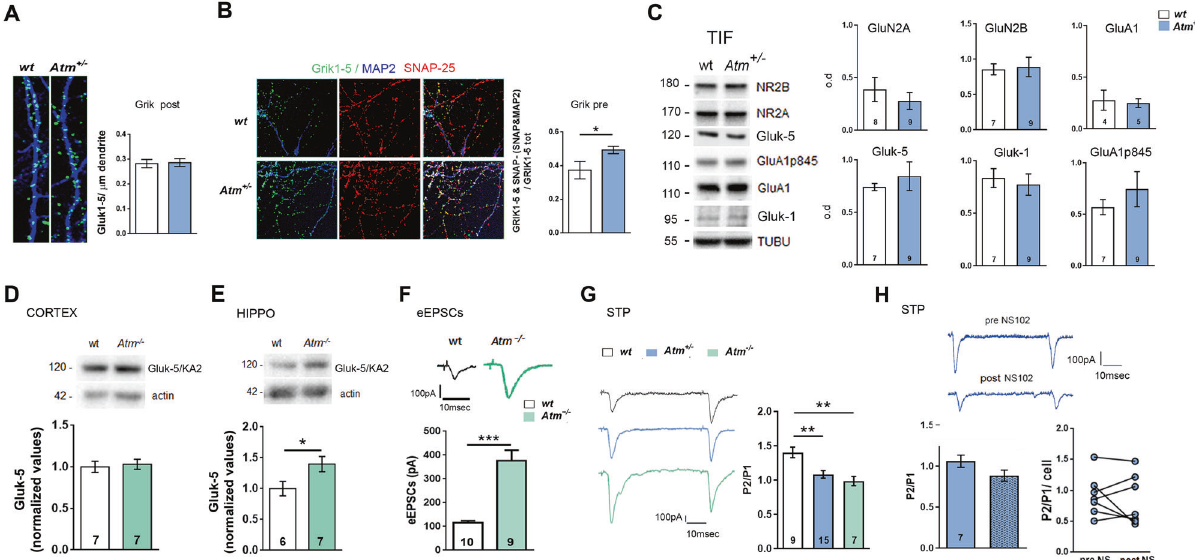
Fig. 5 In ATM de fi cient condition the increased kainate receptors localize at the pre-synapse but do not participate to glutamate release probability. A Immunocytochemical experiments for Grik1 – 5 detection (green) at the postsynaptic compartment in wt and Atm + / − cultured neurons per unit length of dendrite (blue; MAP-2 positive fi lament). Number of cultures: wt = 3, Atm + / − = 3; Number of fi elds per each glass are at least 10. Dendrite length = at least 20 m μ . Mann – Whitney test: p = 0.64. B Immunocytochemical experiments performed in wt and Atm + / − cultured neurons against Grik1 – 5 (green), MAP-2 (blue), and SNAP-25 (red) to evaluate amount of presynaptic Grik1 – 5. Since SNAP-25 is also postsynaptic, we excluded Grik1 – 5 and SNAP25 colocalizing puncta onto MAP-2-positive fi laments. Unpaired t -test: p = 0.017. C Left: Representative Triton-insoluble fraction (TIF) lanes. Right : TIF analysis on hippocampal tissues from wt and Atm + / − mice show comparable levels of Gluk-5 and Gluk-1 KARs subunits (Gluk-5: 2-tailed unpaired t -test p = 0.55, Gluk-1: 2-tailed unpaired t -test p = 0.65), no changes in GluA1 or its 845-residue phosphorylated form (GluA1: Mann – Whitney test p > 0.99; GluA1-p845: 2-tailed unpaired t -test p = 0.409) as well as NMDA receptors subunits, GluN2B and GluN2A (GluN2A: 2-tailed unpaired t -test p = 0.14; GluN2B 2-tailed unpaired t -test p = 0.84). D and E Gluk-5 protein levels are increased in the hippocampus of Atm − / − mice but not in the cortex. t test: p = 0.041. F Representative traces of eEPSCs in wt and Atm − / − cultures and quantitative analysis (eEPSCs amplitude: Mann – Whitney test: p < 0.0001). Independent experiments = 3. G Traces of short-term plasticity (STP) experiments. In mono-synaptically connected neurons, we stimulated pre-synapses with two consecutive stimuli at 50 ms of inter-spike interval and quanti fi ed PPR (P2/P1). P2/P1: Kruskal – Wallis followed by Dunn ’ s multiple comparison test: p = 0.0003. Independent experiments = 3. H Representative traces of short-term plasticity experiments performed in Atm + / − neurons before and after NS-102 delivery. Mean analysis of P2/P1 indicate that KARs receptor are not involved in STP mechanisms (P2/P1: Mann – Whitney test: p = 0.15). Similar results may be evidenced by the analysis of P2/P1 in each cell (dot) before and after NS-102 delivery (P2/ P1: Wilcoxon matched-pairs signed rank test: p = 0.34). Independent experiments =